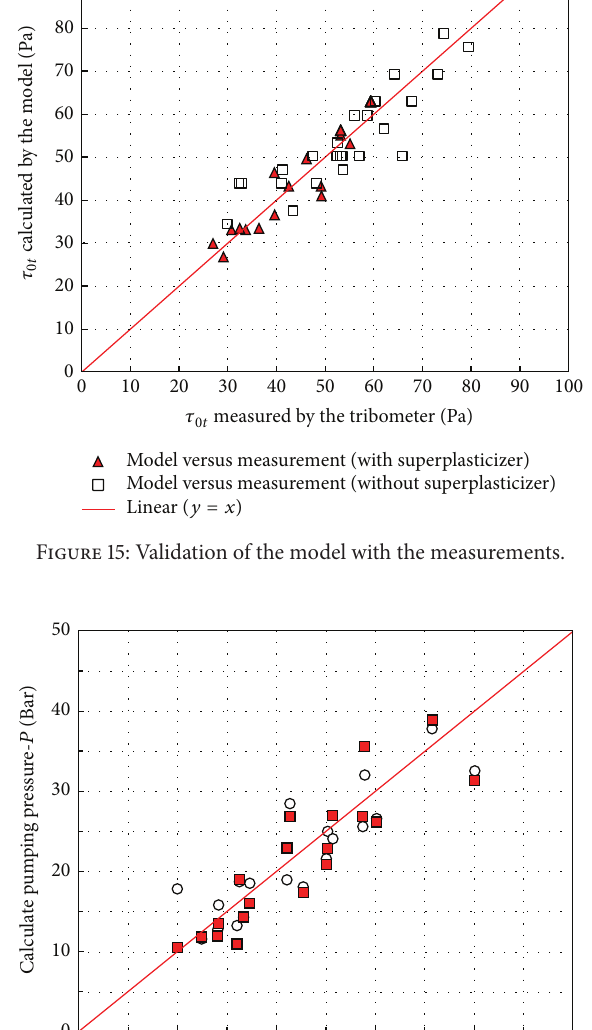
pressureMeasurement P exp . -experimental pumping pressure P th -theorical pumping Figure 16: Comparison of the pumping pressure calculated using the authors’ models ( 𝜂 model and 𝜏 0𝑡 model) and that calculated using measurements of